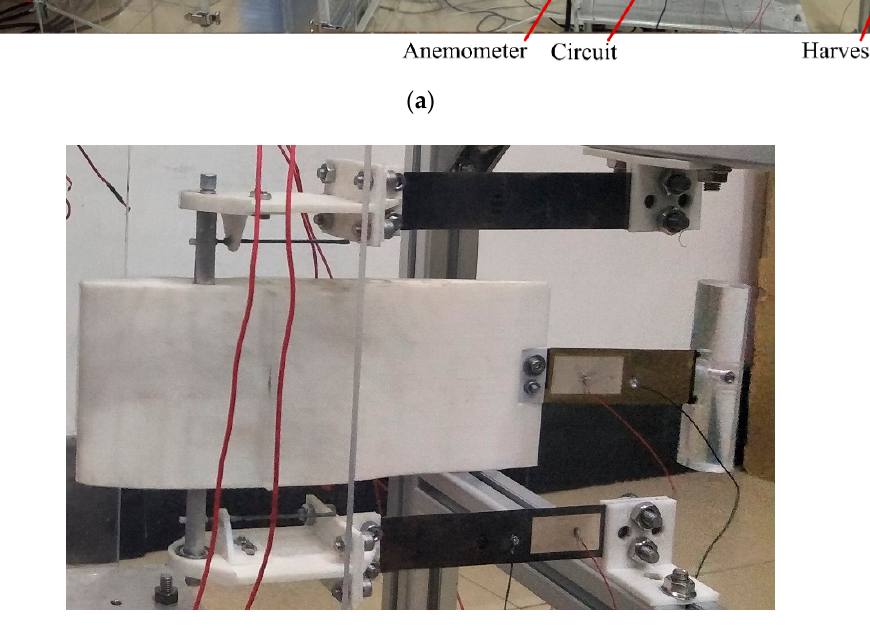
Table 1. Dimensions and materials parameters of the harvester system.